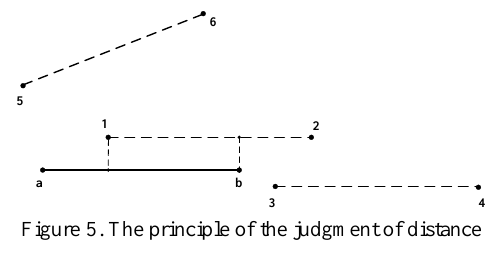
Figure 5. The principle of the judgment of distance